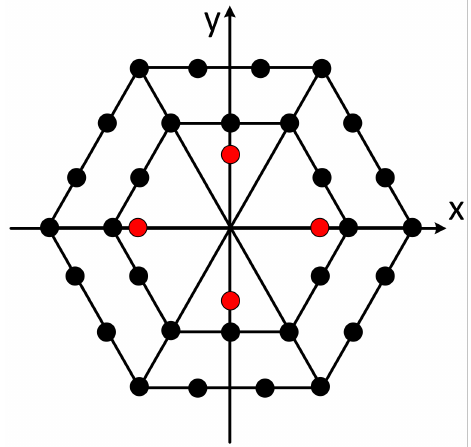
Figure 11. Virtual ultra-short baseline (red is the virtual original). Through the beam former corresponding to four subarrays, the signal received by the 30 receiving elements outputs four time-domain waveforms as the received signal of the virtual ultra-short baseline, and then uses the basic principle of the traditional four element ultra-short baseline to resolve the signal incident direction, which can effectively suppress noise and improve the signal-to-noise ratio, thus improving the operating range and positioning accuracy of the ultra-short